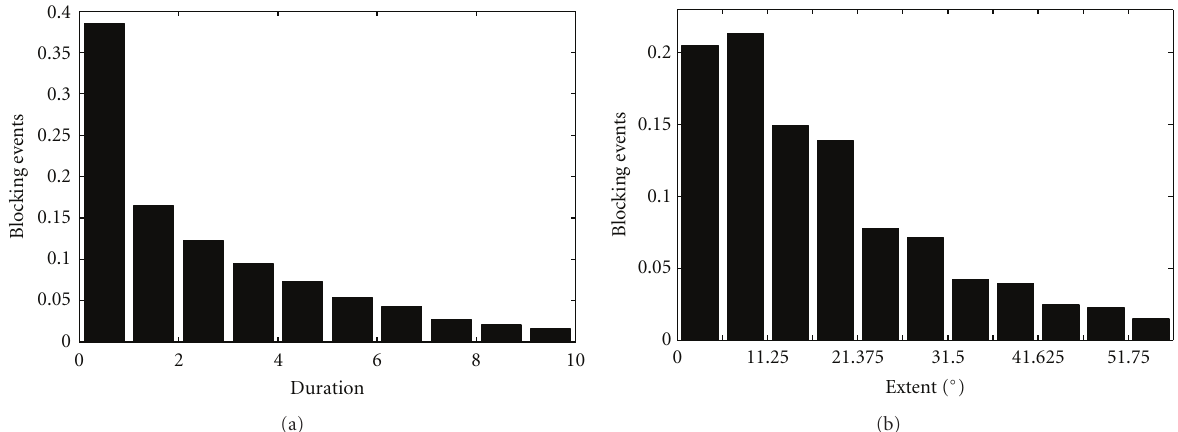
Figure 8: Histograms of the number of blocking events for increasing (a) persistence filter threshold and (b) extent filter threshold.